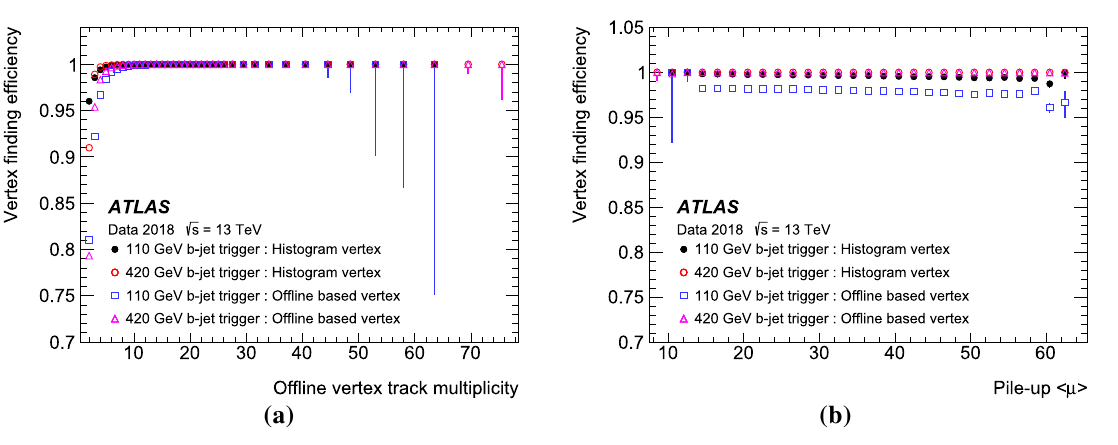
Fig. 42 The vertex algorithm efficiencies for intermediate and high E T b -jet triggers. Shown are the efficiencies a versus the offline track multiplicity for tracks in the super RoI; and b versus the mean pile-